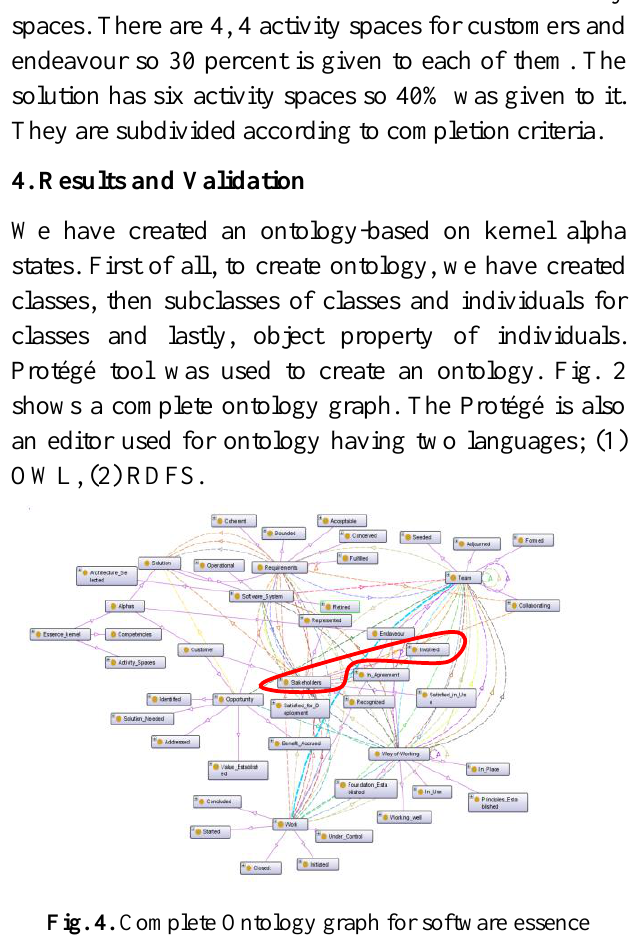
Fig. 4. Complete Ontology graph for software